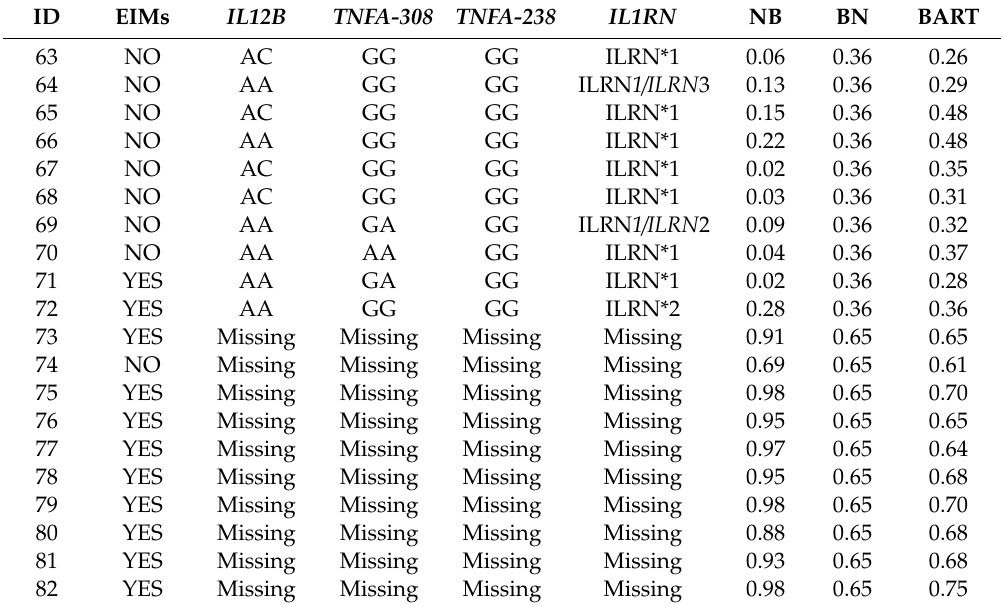
Table 4. Average individual predicted probabilities for the presence of EIMs assigned by each model across each bootstrap replicate of the original sample. From the patient with ID = 73 to the last patient, entries for the genetic factors IL12B , TNFA-308 , TNFA-238 , and IL1RN were systematically